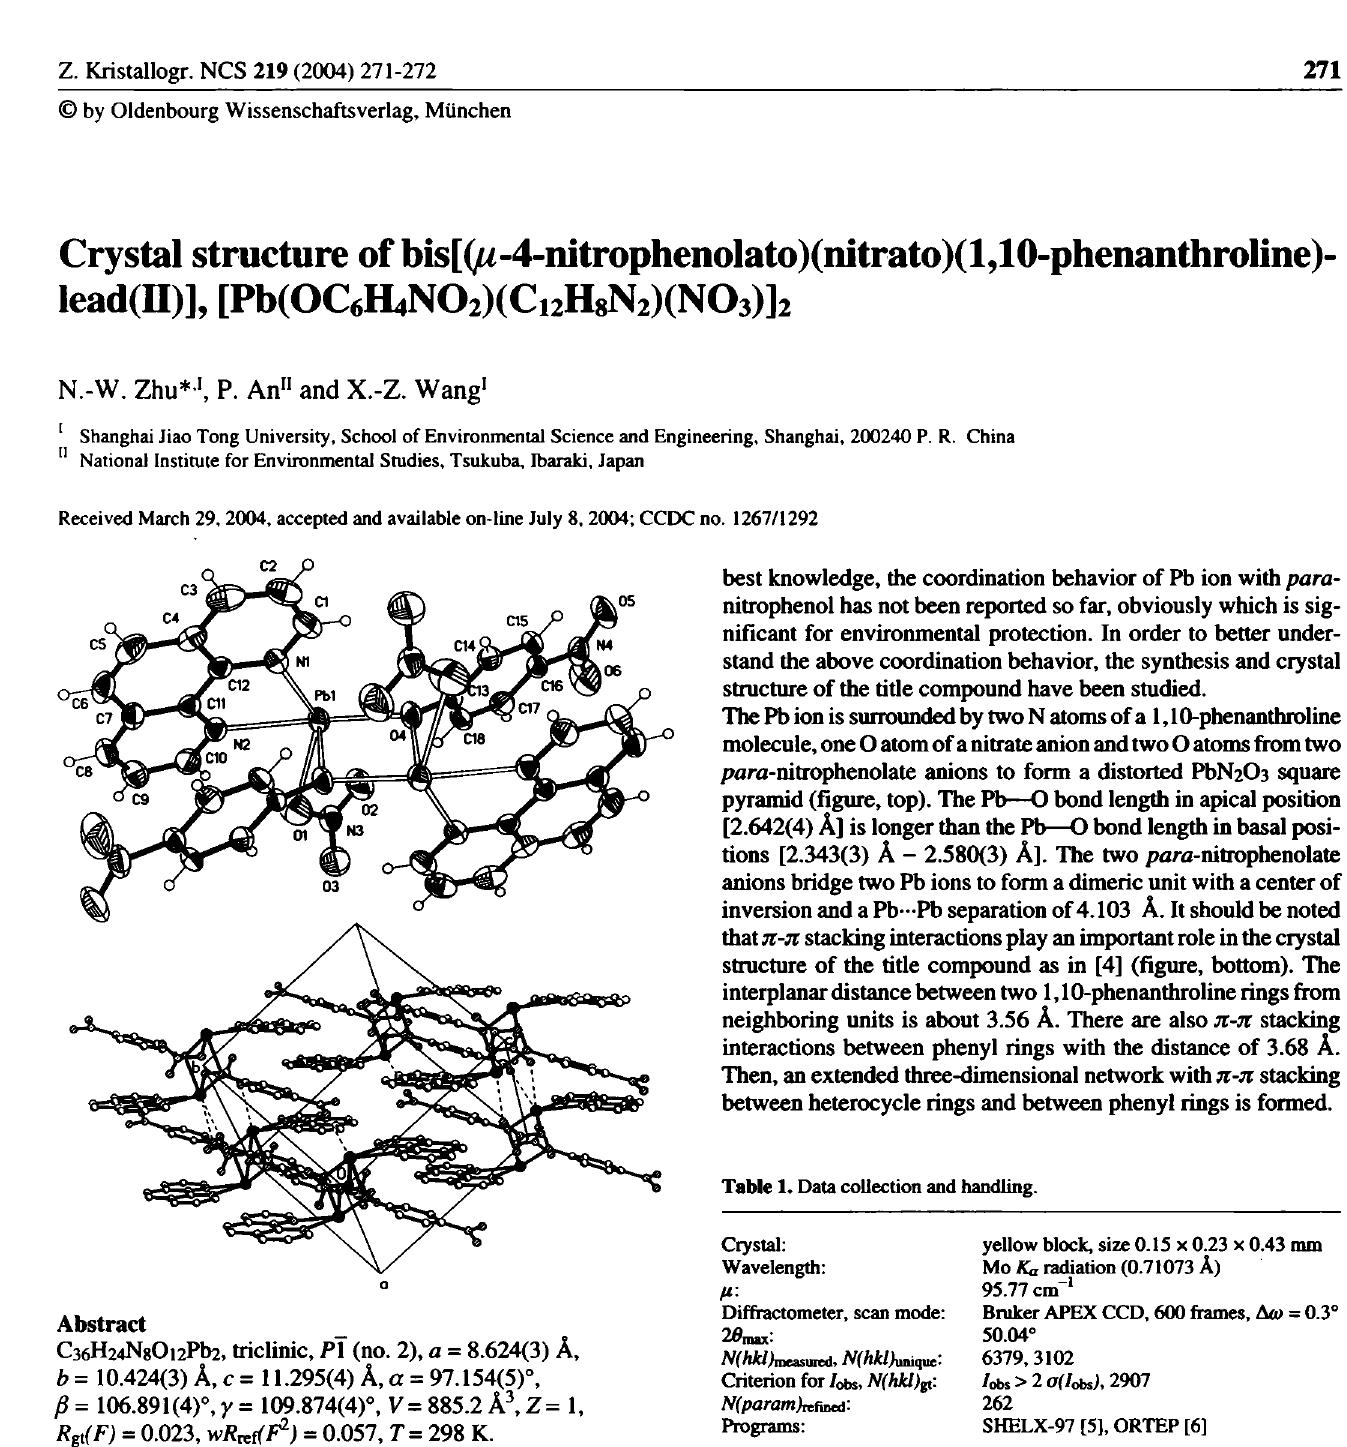
Table 2. Atomic coordinates and displacement parameters (in Â 2